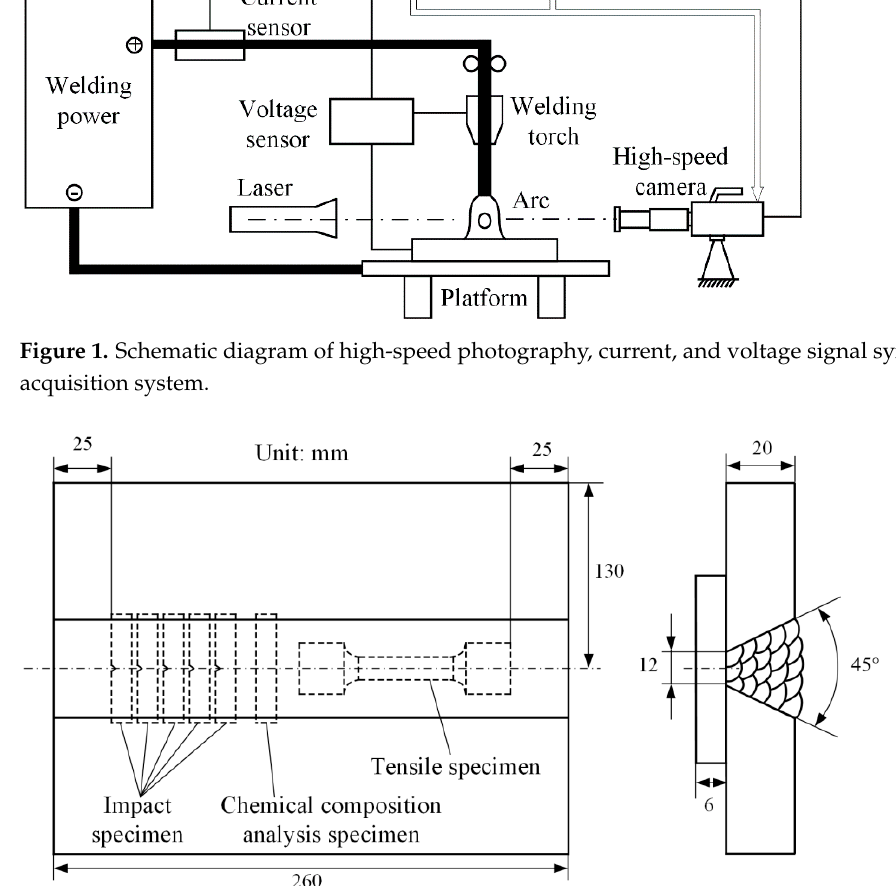
Figure 3. The size of the tensile specimen. 3. Results and Discussion 3.1. Effect of Arc Length on Oxygen Content of Weld Metal Figure 4 shows the oxygen content of weld metal under different arc lengths. As the arc length rises from 2.9 mm to 9.2 mm, the oxygen content increased by 71.4%, significantly from 217 ppm to 372 ppm. When the arc length was 4.5 mm and 9.2 mm, the oxygen content of weld metal was 235 ppm and 284 ppm, respectively.